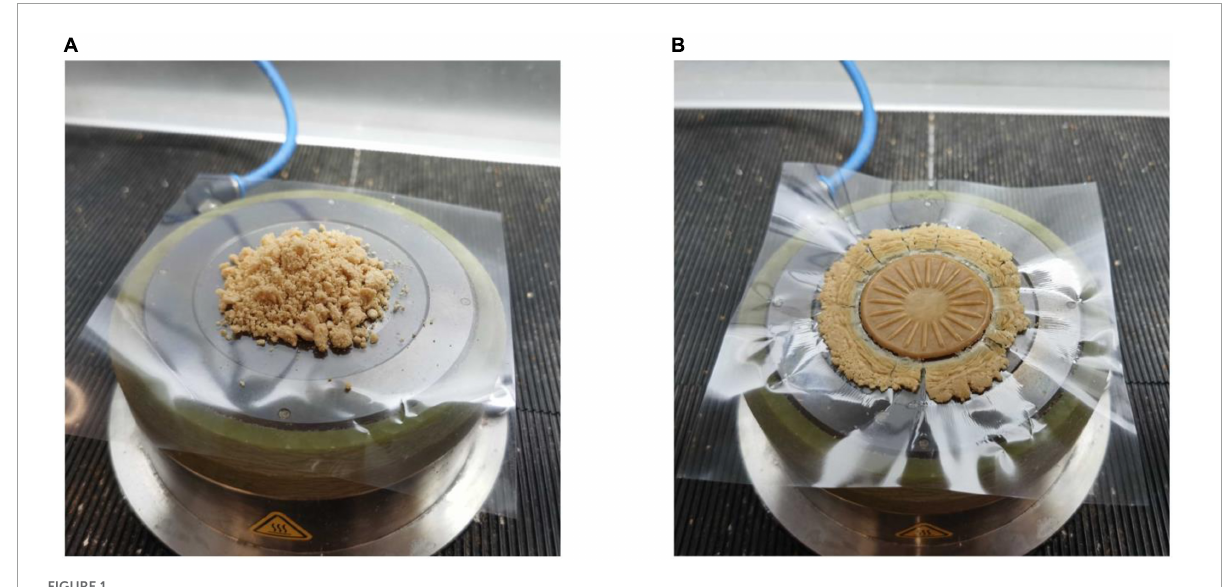
FIGURE1 50 wt% PPI before (A) and after (B) measurement in the closed cavity rheometer.